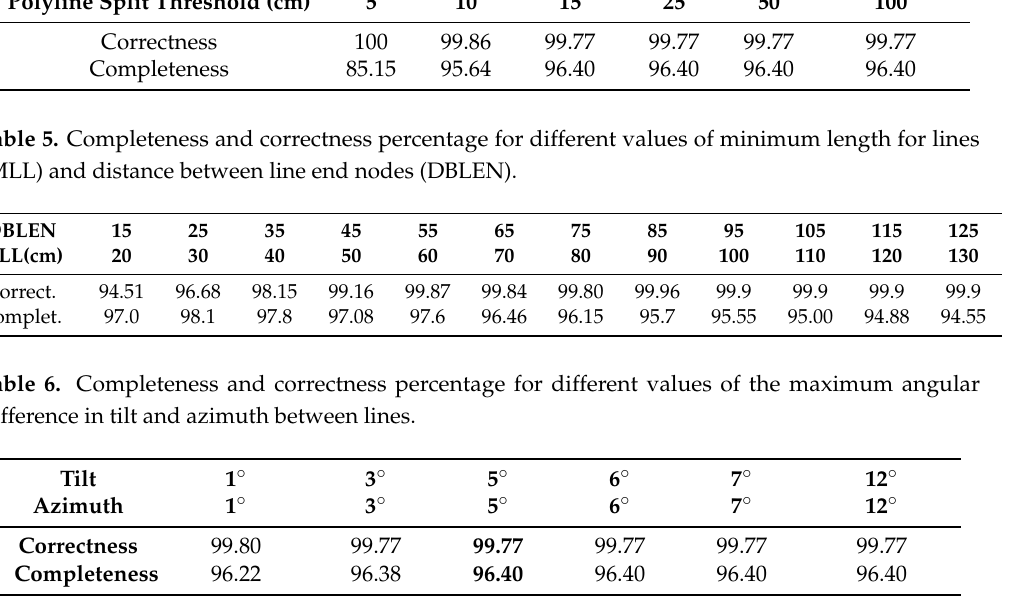
Table 4. Completeness and correctness percentage for different values of the polyline split threshold. Correct. 99.97 Polyline Split Threshold (cm) Table 5. Completeness and correctness percentage for different values of minimum length for lines (MLL) and distance between line end nodes (DBLEN).